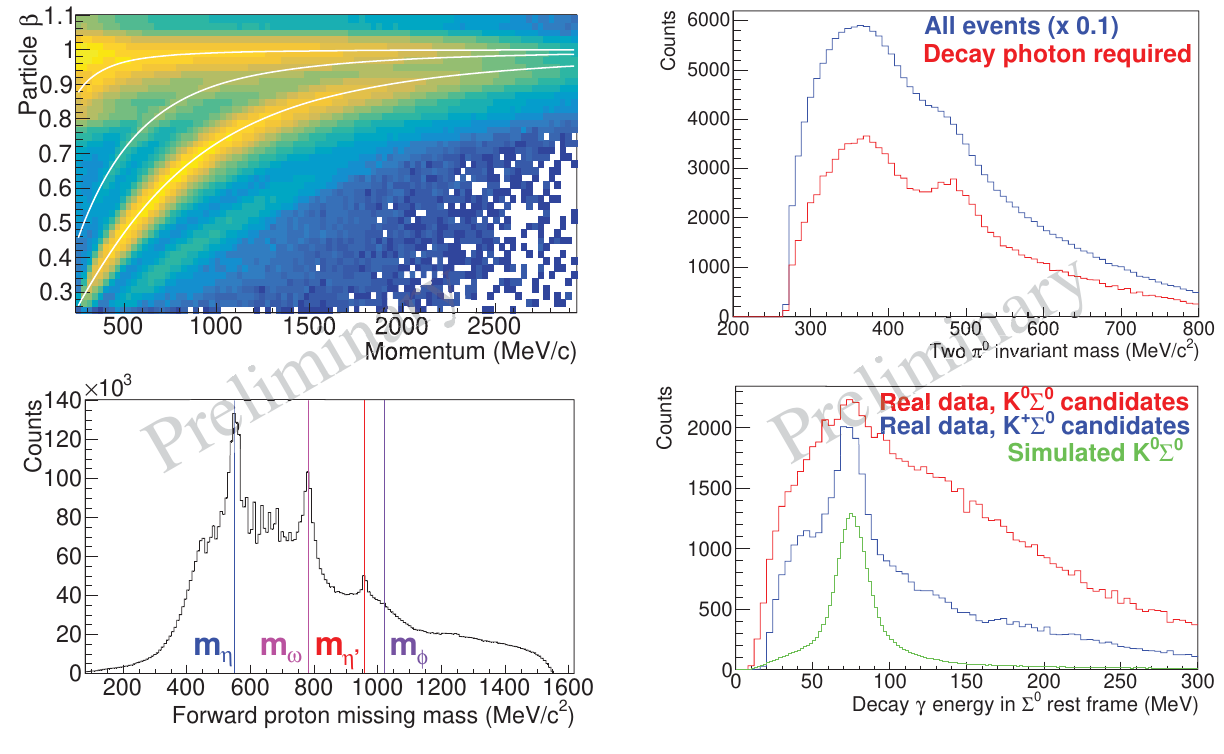
Figure 7. Particle identification in the forward spectrometer. Top: β versus momentum. Characteristic loci for π + , protons and K + are indicated by white lines. Bottom: Mass recoiling from forward particles. Peaks from single meson photoproduction in- dicated.